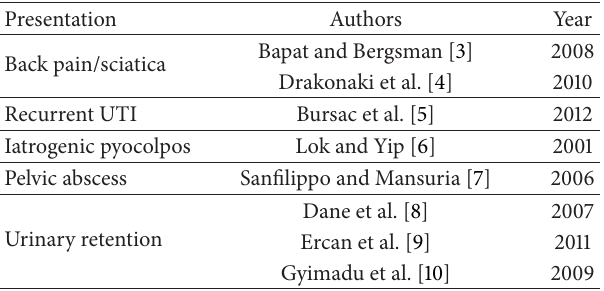
Figure 5: Image from diagnostic laparoscopy procedure. Table 1: Unusual presentations of imperforate